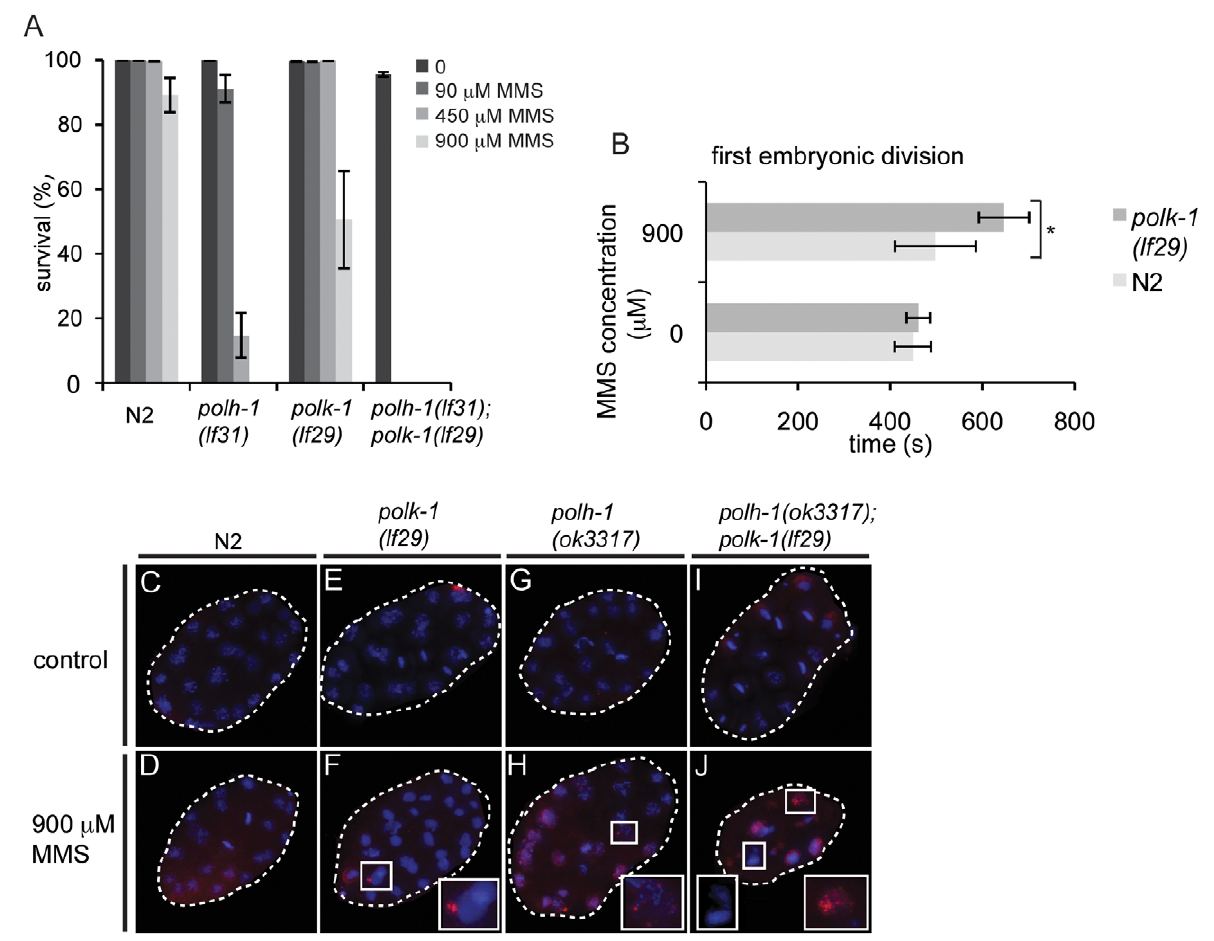
Figure 5. polh-1 and polk-1 protect in a redundant fashion against the methylating agent MMS. (A) Double mutants of polh-1 and polk-1 are severely sensitized to MMS exposure. Results of a representative experiment are shown. Error bars denote SD. (B) Delayed progression through the first embryonic division after MMS exposure in polk-1 mutants. The interval between passing of the paternal pronucleus over the midline till the start of cytokinesis is timed for at least 5 embryos per datapoint. Statistical significance for the difference in delay between N2 and polk-1 embryos treated with MMS was calculated with a student’s t-test (p=0.012). (C–J) RAD51 immunostainings of early embryos treated with MMS. Morphology of polh-1; polk-1 double mutant embryos is abnormal after MMS exposure, displaying chromatin bridges and abundant RAD51 staining (J).